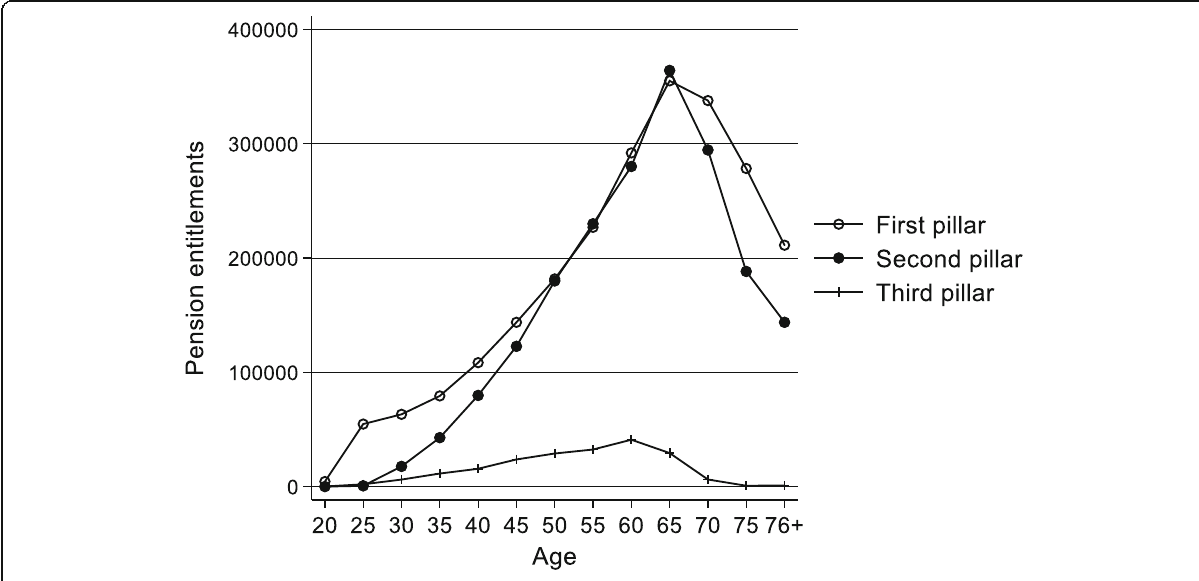
Fig. 6 Personal pension entitlements in 2015 by age Note: values refer to the mean values of 5-year age groups. Weighted data. Source: linked data from SILC 2015 (experimental wealth data from 7 June 2018) and administrative